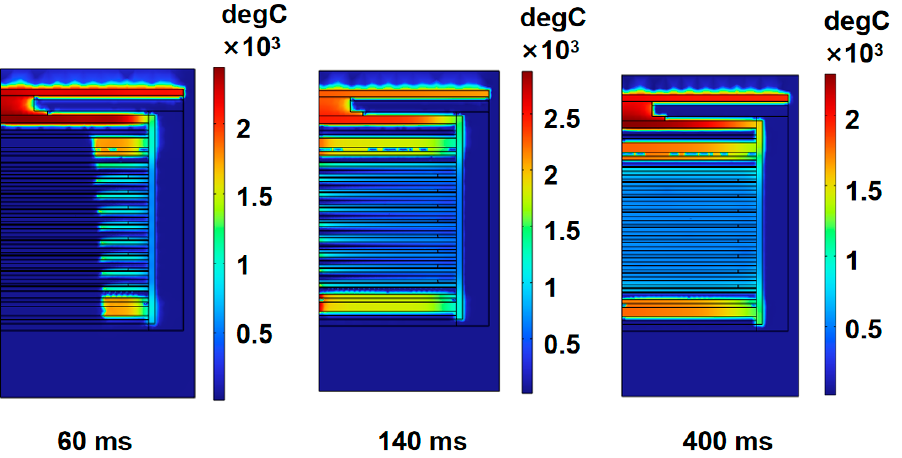
Figure 4. Temperature cloud of thermal battery at different times.